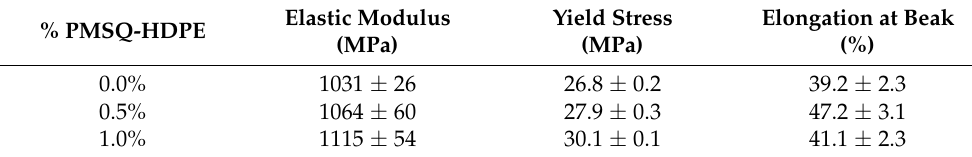
Table 2. Tensile mechanical properties of high-density polyethylene (HDPE)-PMSQ nanocomposites [16]. % PMSQ-HDPE